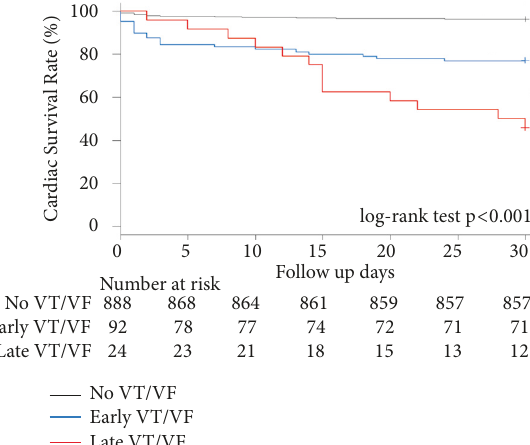
Figure 2: Clinical outcomes regarding cardiac survival rate between patients without VT/VF and those with VT/VF during the 30- day period. Notes: log-rank test p < 0.001 for comparisons between patients without VT/VF and those with VT/VF. VT/VF: ventricular tachycardia or ventricular fibrillation.